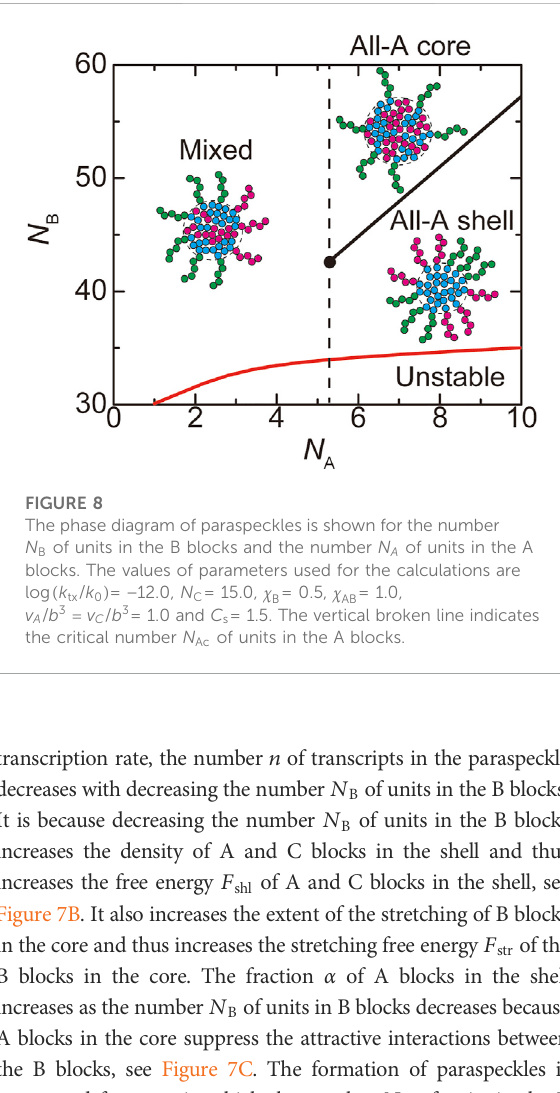
The radius r C / b (A) , the number n of transcripts (B) , and the fraction α of the A blocks in the shell (C) of a paraspeckle is shown as functions of the number N B of units in the B blocks for cases in which the number N A of units in the A blocks is 3.0 (light green), 5.33231 (black), and 8.0 (orange). The (natural) logarithm log ( k tx / k 0 ) of the transcription rate is fi xed to − 12.0. The values of parameters used for the calculations are N C = 15.0, χ B = 0.5, χ AB = 1.0, v A / b 3 (cid:1) v C / b 3 = 1.0, and C s = 1.5.